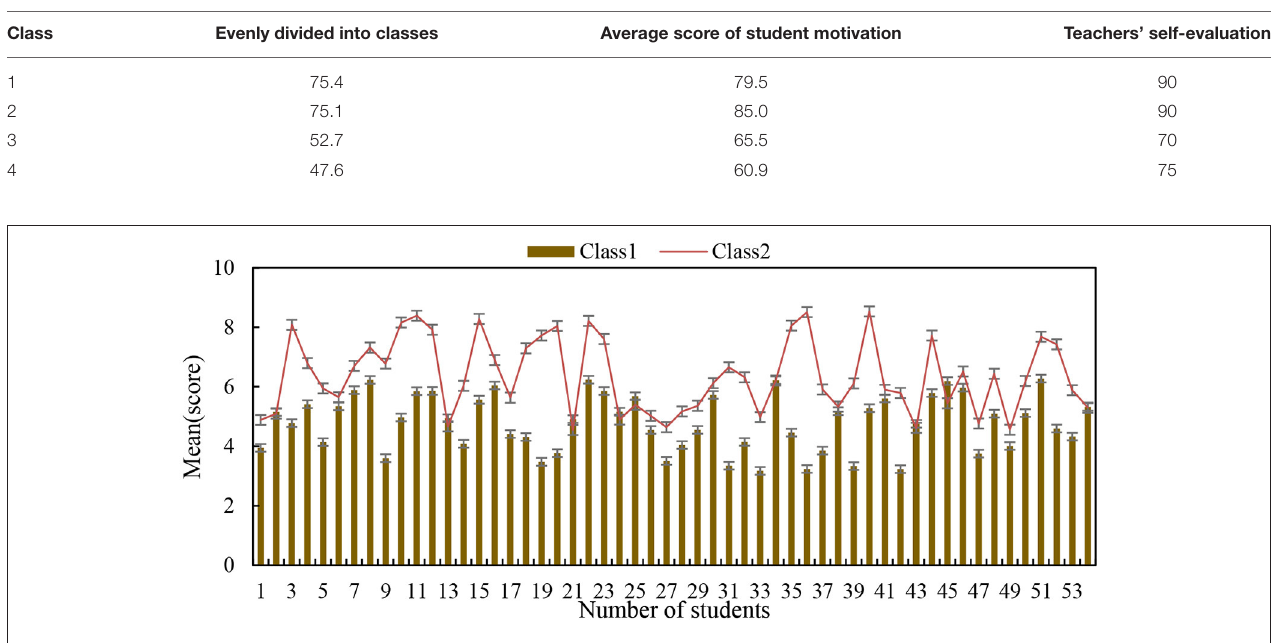
FIGURE 13 | Pretest results comparison between the experimental class and the control class.